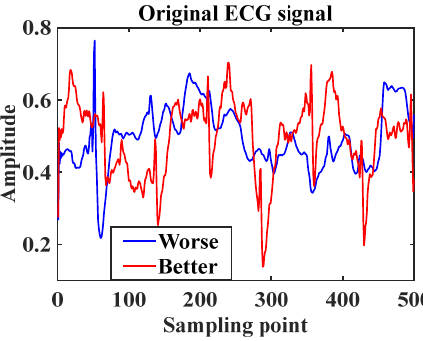
Figure 3. The time domain ECG signal wave of different wellness statuses.